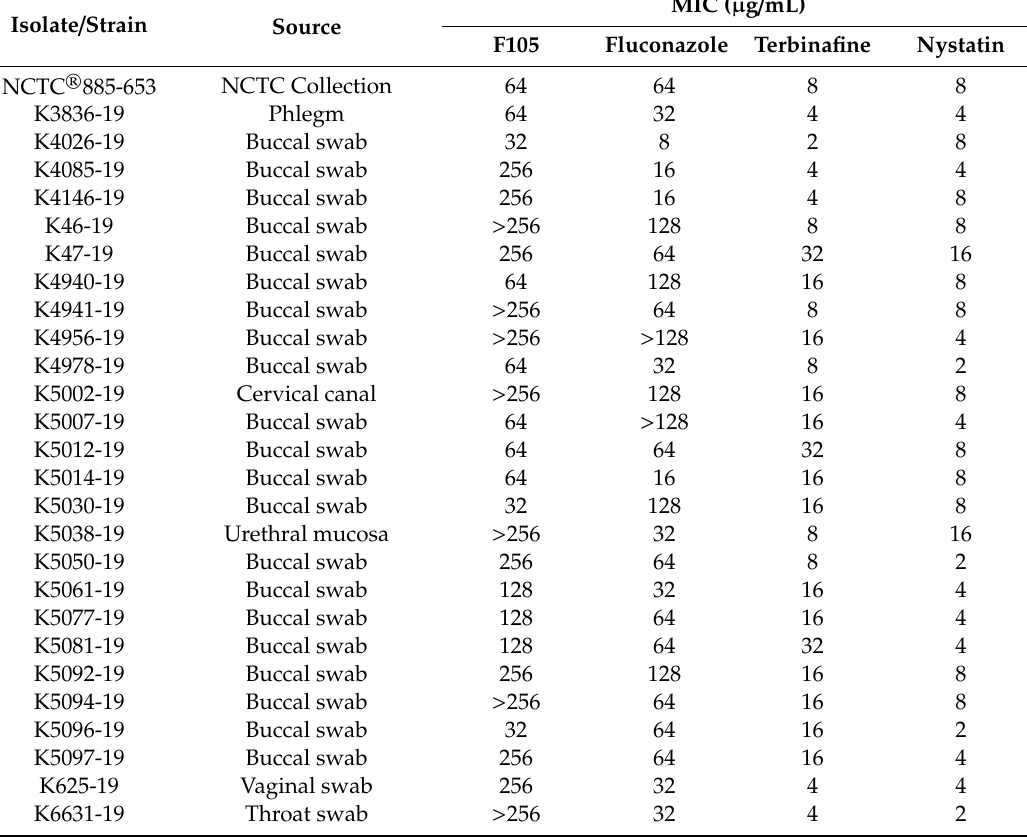
Table 1. Susceptibility of Candida albicans clinical isolates to F105 and conventional antimycotics. Isolate / Strain